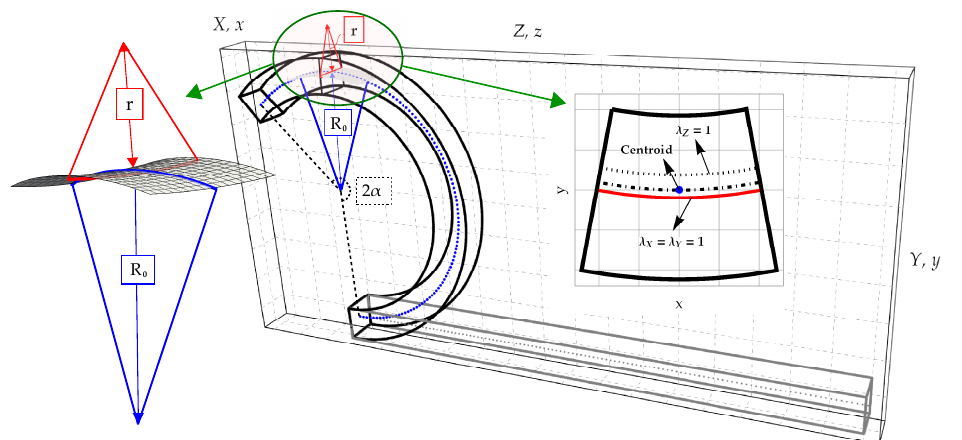
Figure 1. Prismatic hyperelastic solid under bending: Kinematic parameters, anticlastic surface and deformed configuration of the cross